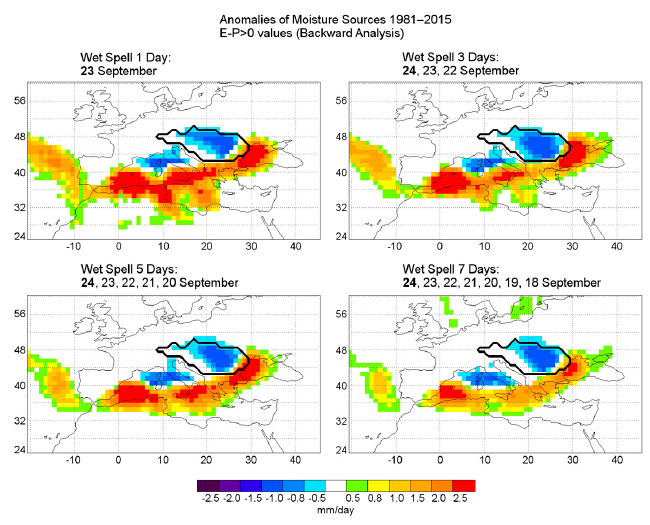
Figure 7. Anomalies of moisture sources obtained from the backward analysis (E − P > 0 values) for the different time scale for the 23 September 1996 wet spell. The black line contour corresponds to the Danube River Basin. Scale in mm/day. The negative values in the field E − P > 0 anomalies over the Danube River Basin (Figure 7 top right hand) are in concordance with the convergence in Figure 5 (right panel) and the highest amounts of precipitation.